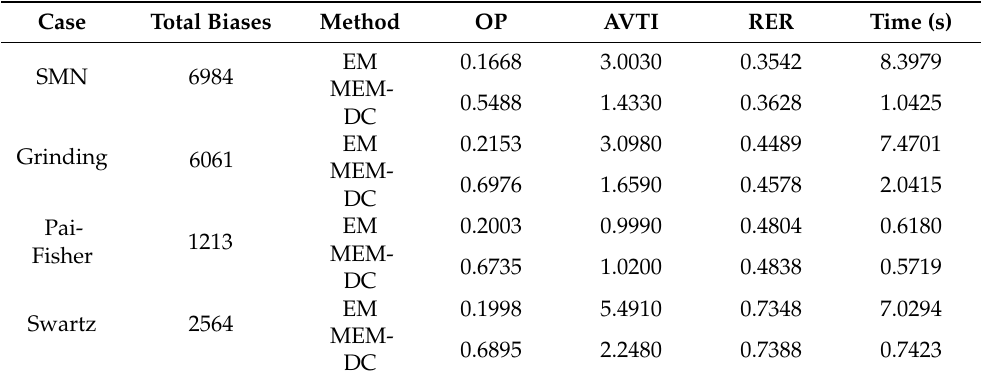
Table 3. The performances of the original and modified EM approaches for the tested